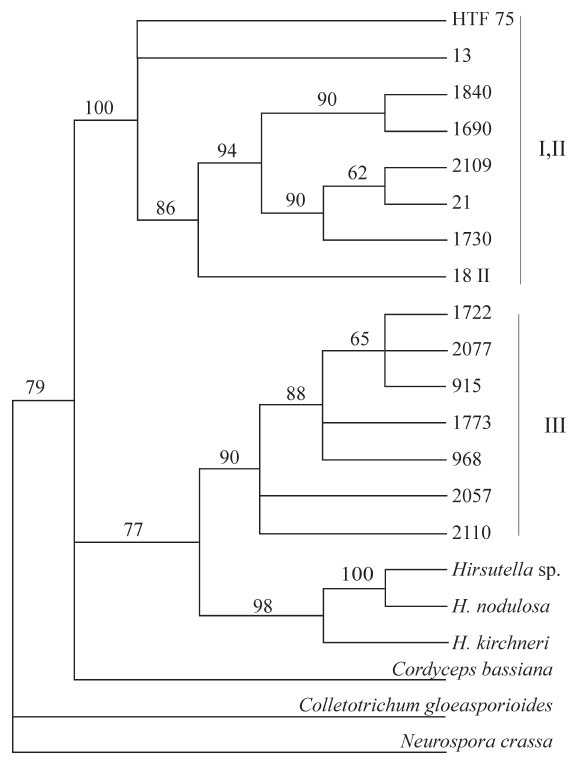
Figure 4 - Maximum likelihood tree based on (cid:2) -tubulin sequences. Num- bers next to the branches are bootstrap percentage values, based on 1,000 replicates. The outgroups are Neurospora crassa and Colletotrichum gloeosporioide